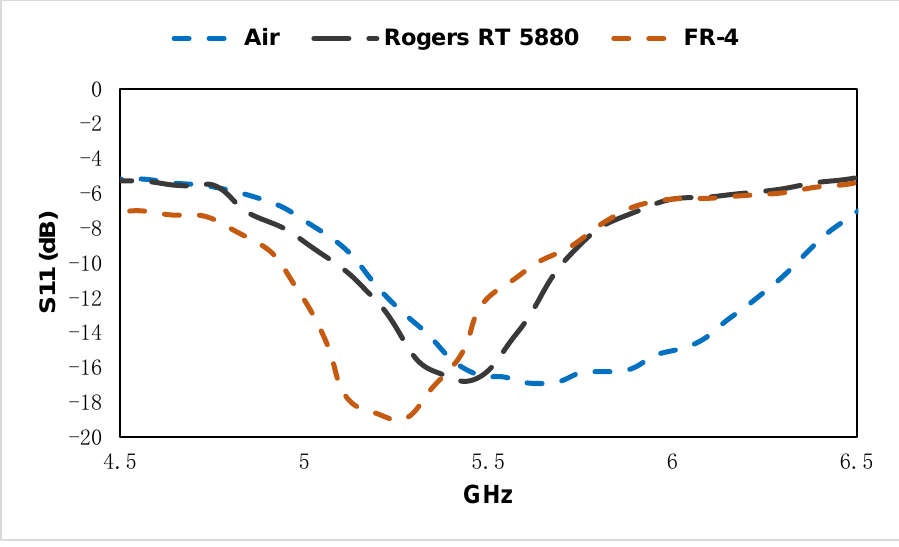
Figure 16. Measured result of the metamaterial-incorporated sensor for different MUTs.